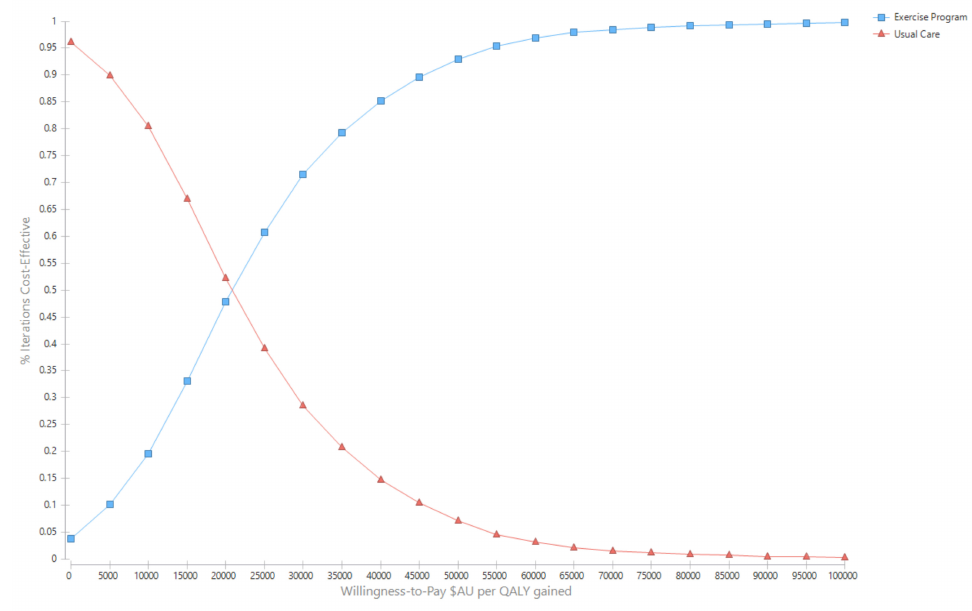
Figure 3. Cost-e ff ectiveness acceptability